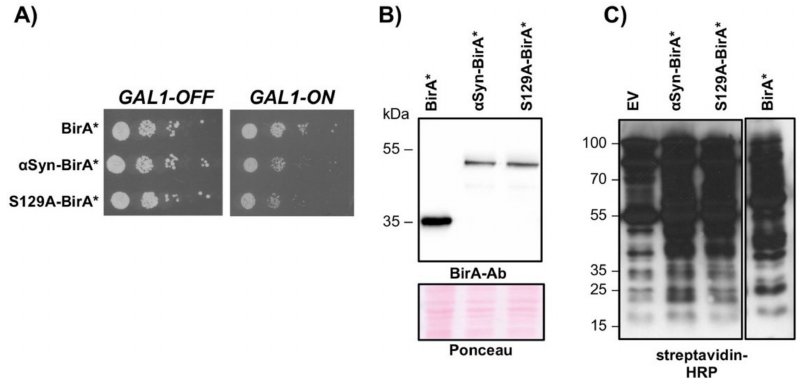
Figure 5. BirA* biotinylates endogenous protein in yeast cells. ( A ) Growth assay of yeast cells, expressing GAL1 -driven BirA*, α Syn-BirA* and S129A-BirA* from a high copy plasmid. ( B ) Immun- odetection of proteins from ( A ) using a BirA-specific antibody. Ponceau staining of the lanes is shown as a loading control. ( C ) Protein biotinylation, detected with horseradish peroxidase (HRP)-coupled streptavidin, is elevated in cells expressing BirA*-fusion proteins or BirA* alone in comparison to the empty vector (EV). Protein expression was induced in galactose-containing medium in the presence of